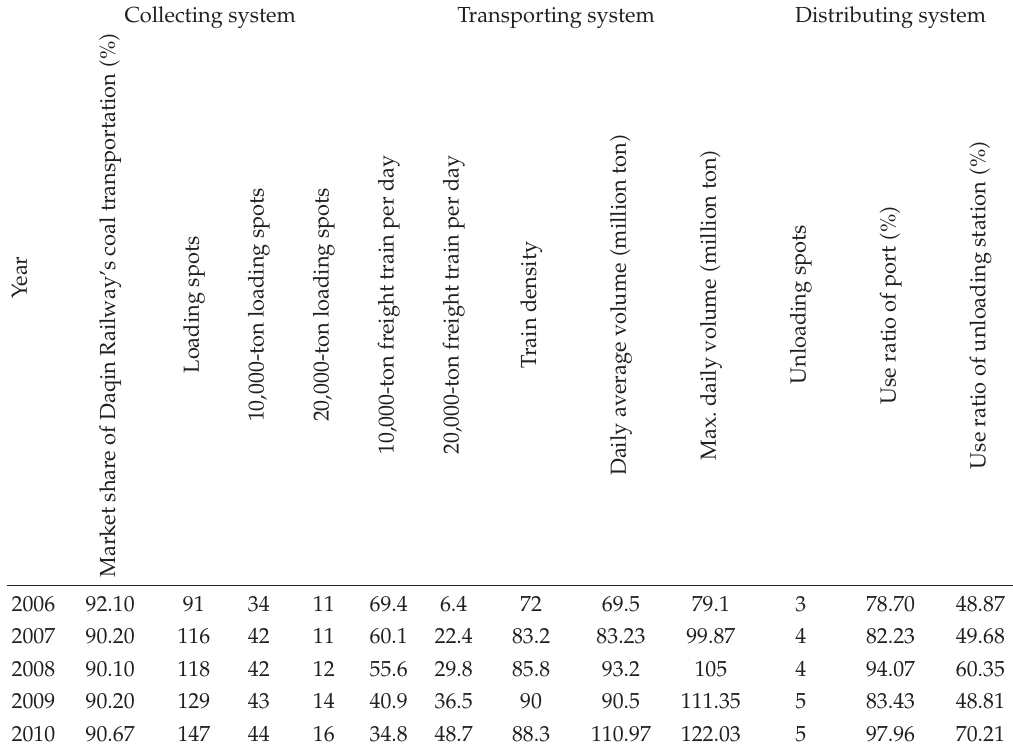
Table 1: The previous data of the collecting, distributing, and transporting system.